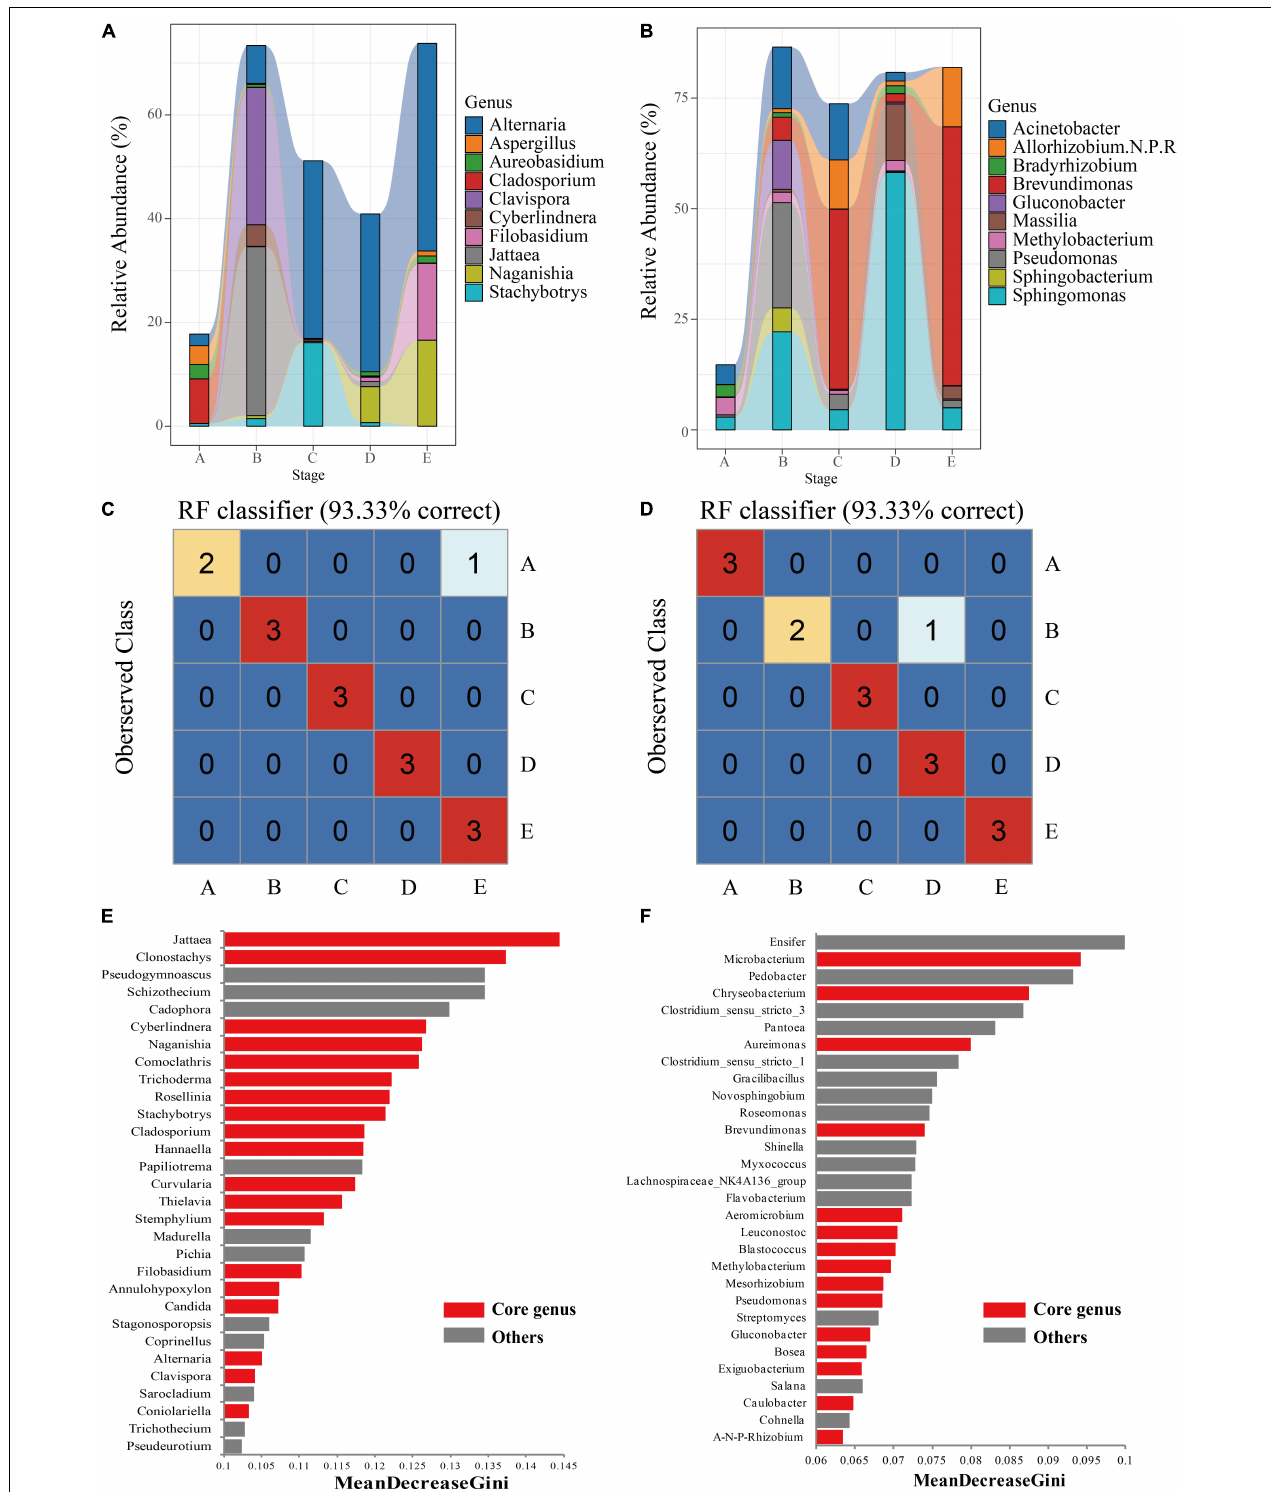
FIGURE 4 | The core microbiome of grape epidermis at different developmental stages. The relative abundance of the core taxa of fungi (A) and bacteria (B) changed with development (relative abundance top 10 shown). The results of the Random Forest model showed that the microbiota of fungi (C) and bacteria (D) could distinguish the developmental stages of grapes. Important taxa of fungi (E) and bacteria (F) are shown based on the MeanDecreaseGini value. A, fruit setting; B, early veraison; C, end veraison; D, mid maturity; E, harvest.